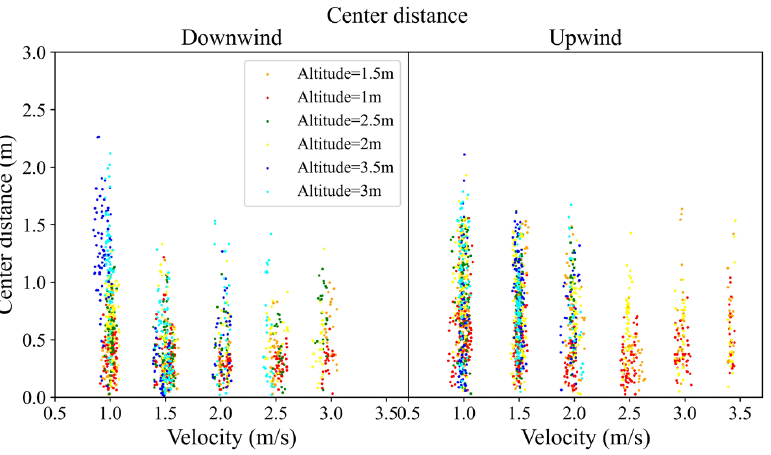
Figure 11. Distance between the center of the inscribed circle and the center of the circumcircle.